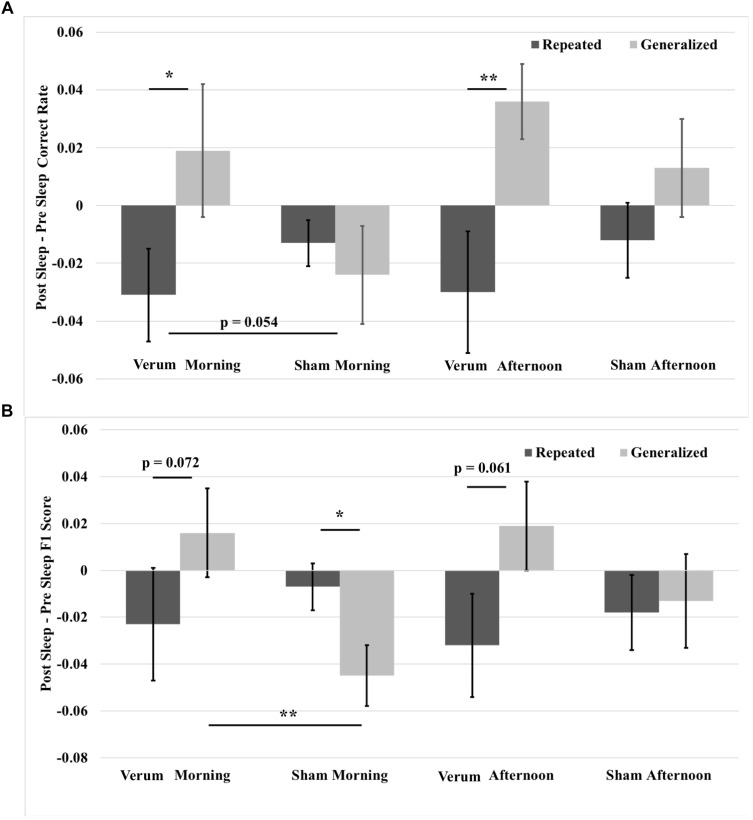
Overnight performance changes from immediate to morning and afternoon tests broken down for repeated and generalized images in the verum and sham stimulation conditions. (A) Overnight correct rate changes. The overnight correct rate change on generalized images was greater than on repeated images for verum stimulation at both morning and afternoon tests. Further, the overnight correct rate change on generalized images at the morning test for verum stimulation was greater than that for sham stimulation at a trend level. (B) Overnight F1 score changes. The overnight F1 score change for generalized images was significantly greater for verum stimulation compared to sham stimulation at the morning test. Further, the overnight F1 score change on generalized images for verum stimulation was greater than on repeated images at both morning and afternoon tests at a trend level. However, the overnight F1 score change on repeated images for sham stimulation was significantly greater than on repeated images at the morning test. Some of the data in (B) is also presented in Ketz et al. (2018), and is further broken down by morning and afternoon tests. ∗p < 0.05, ∗∗p < 0.01, error bars represent ± SEM.